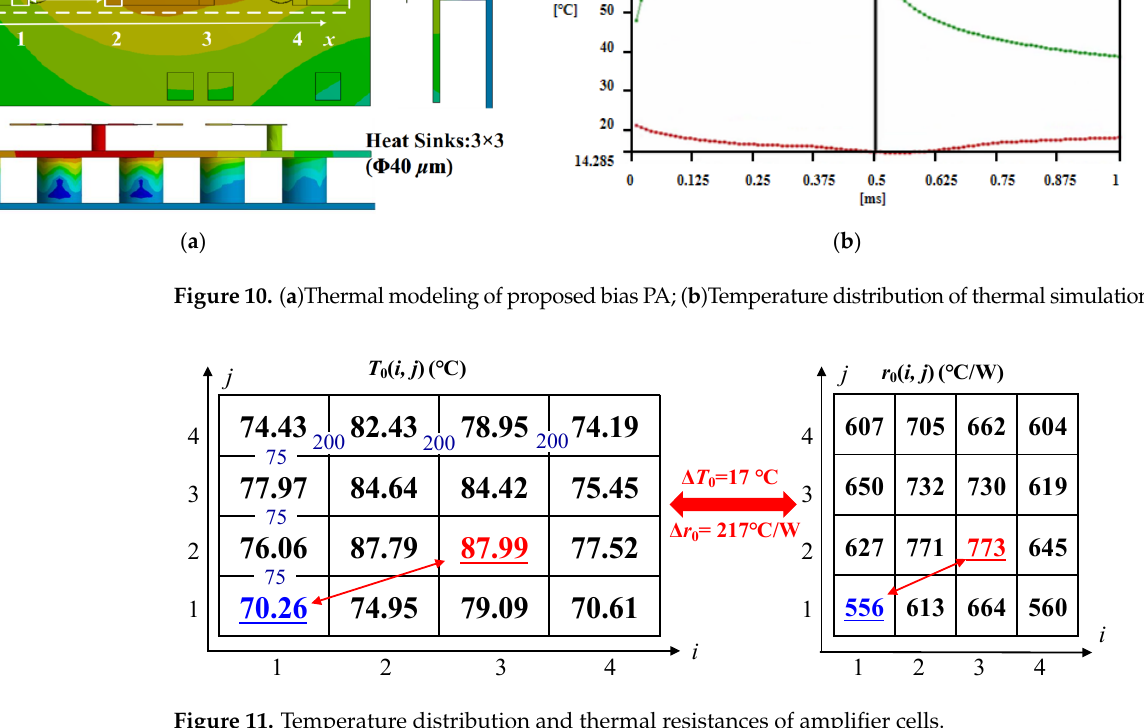
Figure 11. Temperature distribution and thermal resistances of amplifier cells. Table 3. Comparison of the measured results and simulated results.